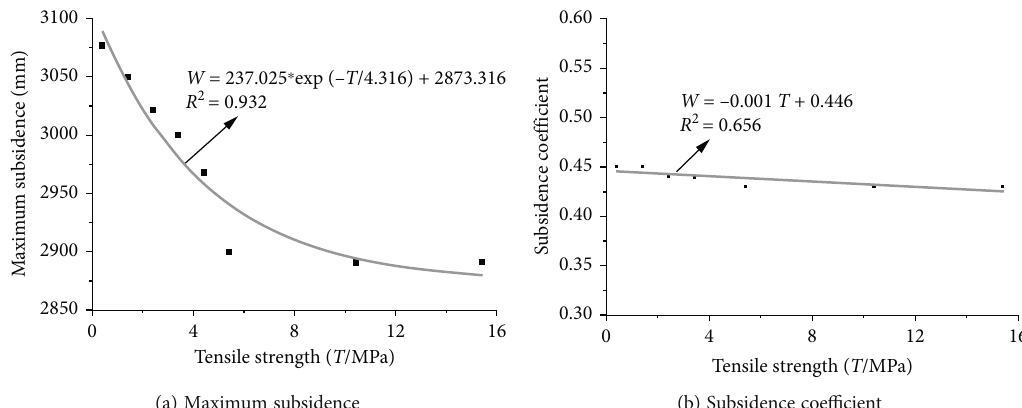
Figure 15: Fitting curve of maximum subsidence/subsidence coe ffi cient and tensile strength.